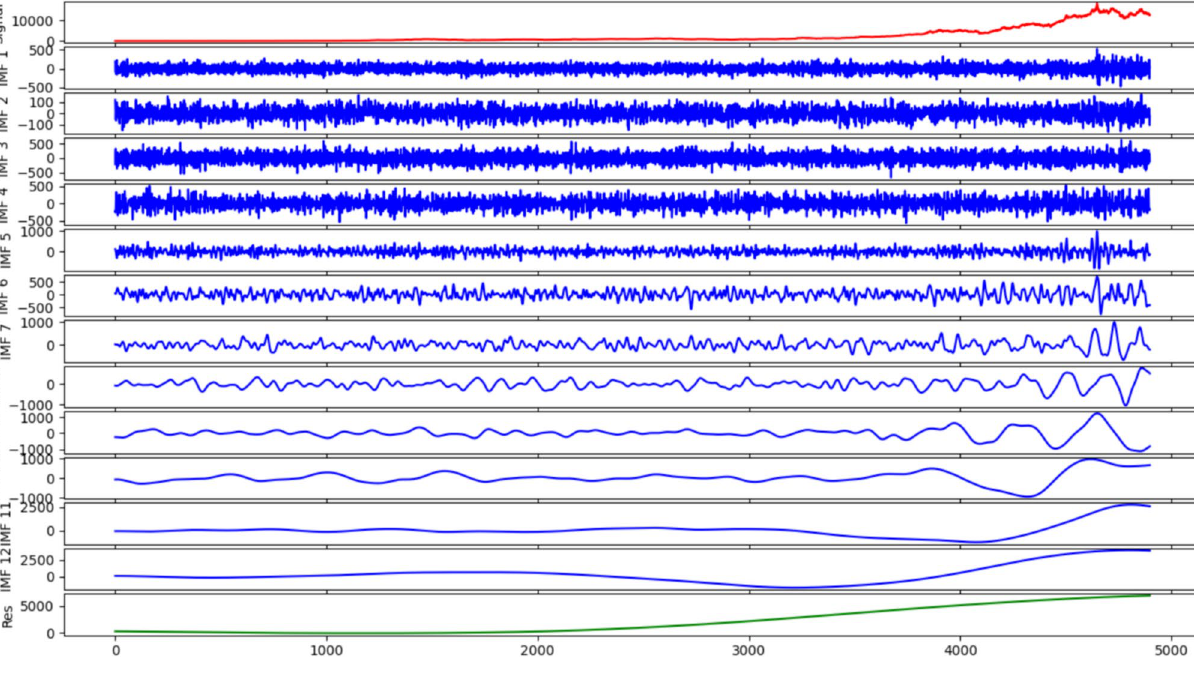
Fig. 4 The decomposition results of CEEMD for SH600519